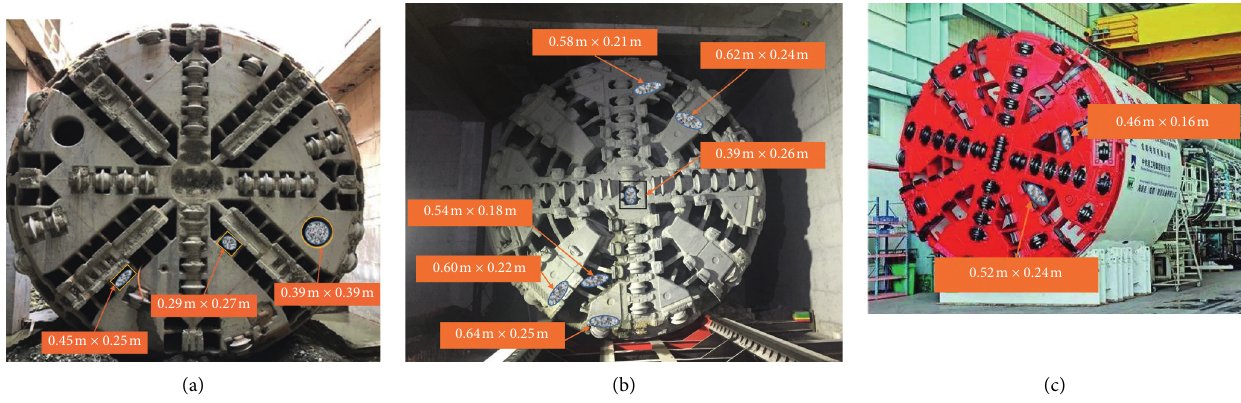
Figure 14: Cutter-heads of the three EPBs: (a) EPB1, (b) EPB2, and (c)